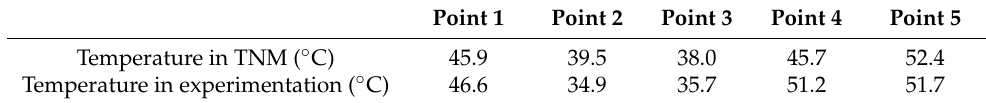
Table 5. Temperatures of some points in the TNM and experimentation.